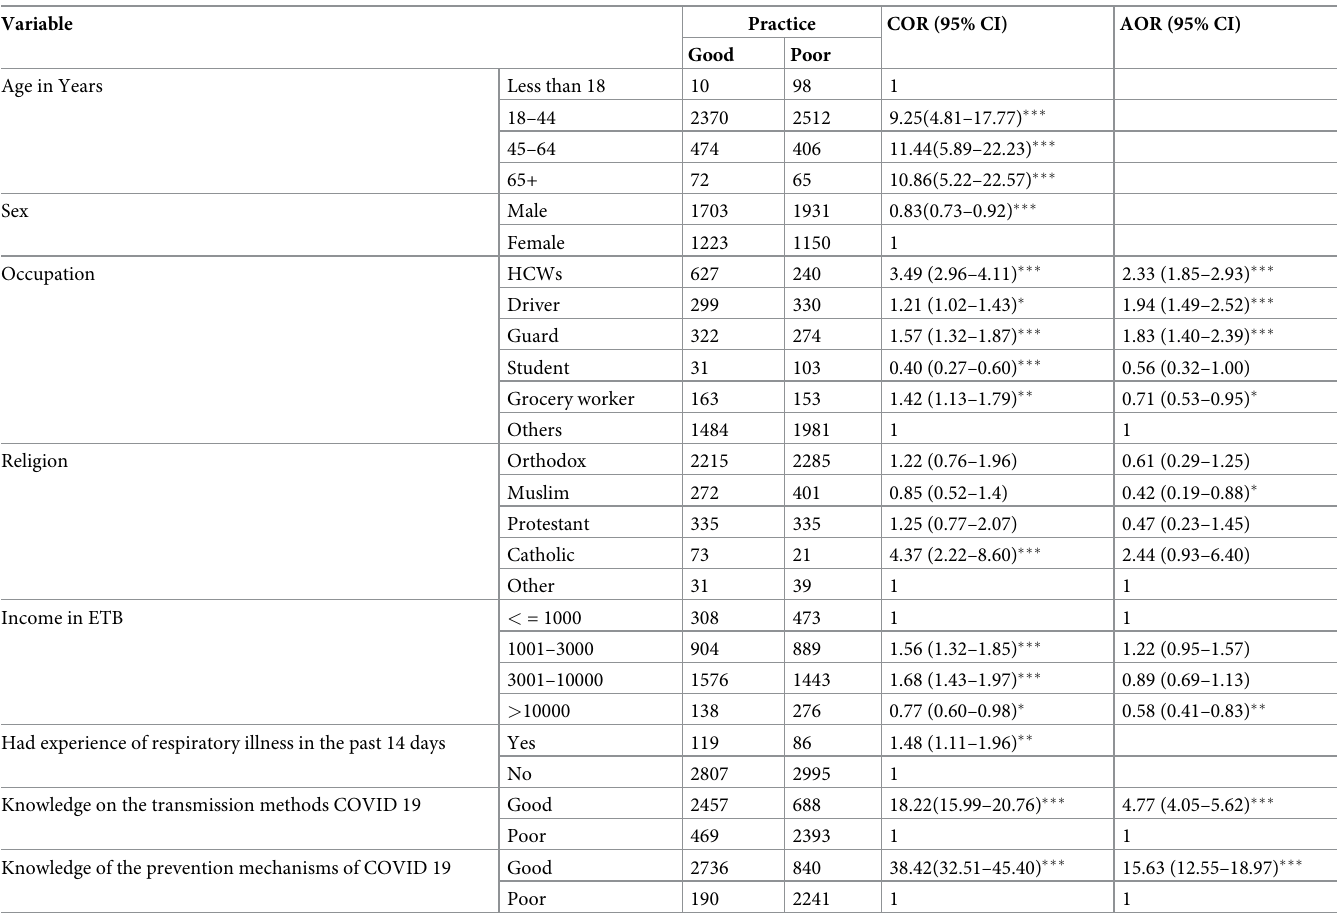
Table 5. Factors associated with the practice of precautionary measures against COVID-19 among participants, Addis Ababa, Ethiopia,